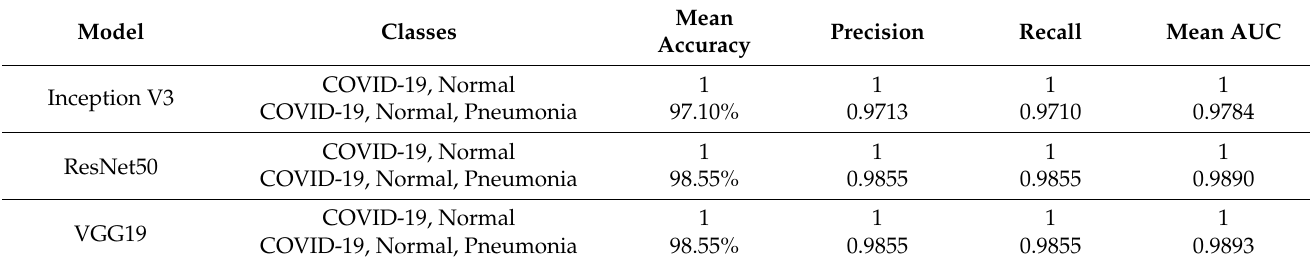
Table 3. Overall performance comparison of 3-class and binary classifier InceptionV3, ResNet50, and VGG19 models. Model Classes